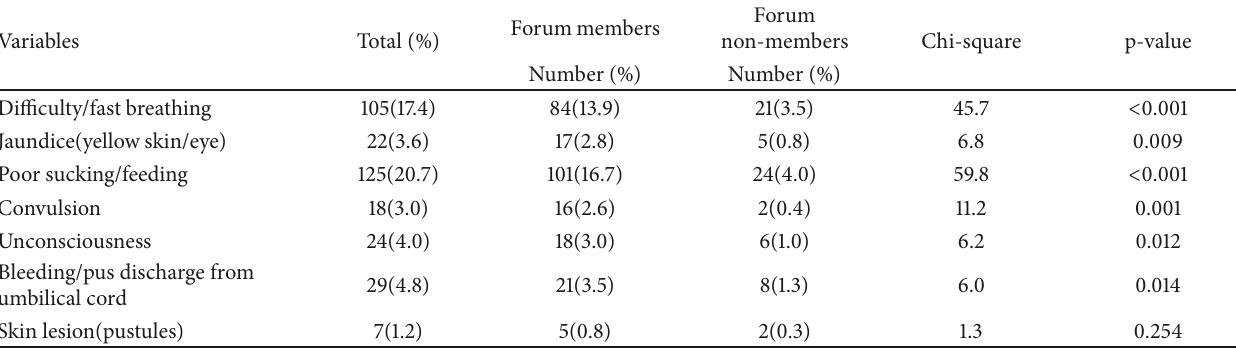
Table 5: Knowledge about danger signs of newborn among pregnant women in Dale Woreda, Sidama Zone, SNNPR, Ethiopia, 2015.